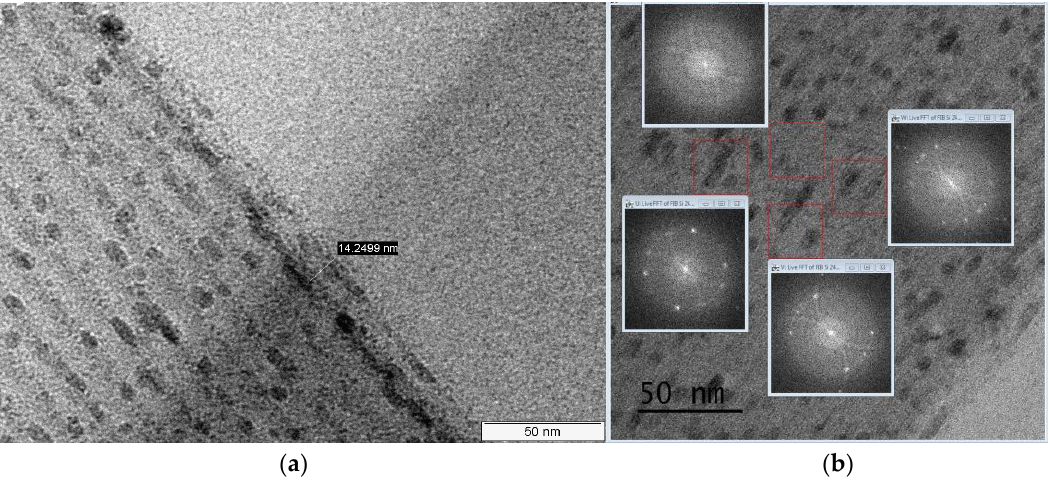
Figure 5. TEM of substrate and multilayer (ML) film ( a ) and FFTs of the same film ( b ).